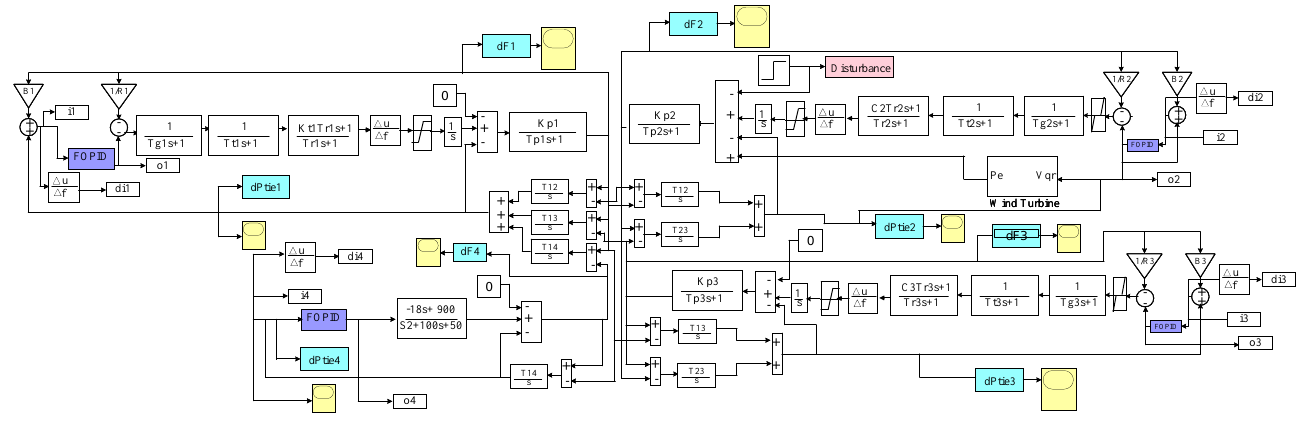
Figure 13. Four interconnected systems scheme. The simulations in this part are implemented by considering two different load distur- bances. The first one is +1% occurring in the load of area 2 (WT based plant). The second one is a sudden step change in the disturbance of the WT based plant where two levels of disruption are recognized: 10% and then a sudden reduction to 1%. The considered levels of the disturbances for the two cases are drawn in Figure 14. The variation in the fitness function (ITAE) with iteration number for the proposed MHGS in comparison with the others for a 1% disturbance applied on a WT based plant (area 2) is shown in Figure 15. The curves confirm the superiority of the proposed MHGS as it achieves the minimum fitness function.